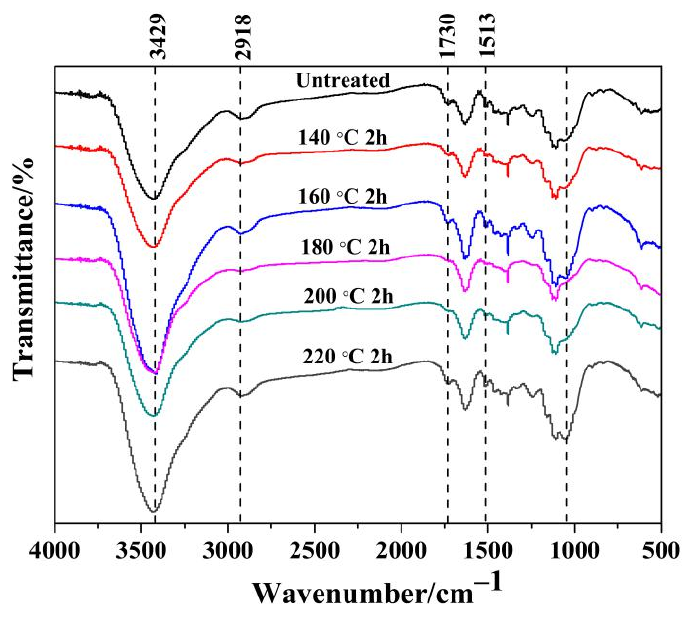
Figure 3. Infrared spectrum of bamboo fiber treated in vacuum.